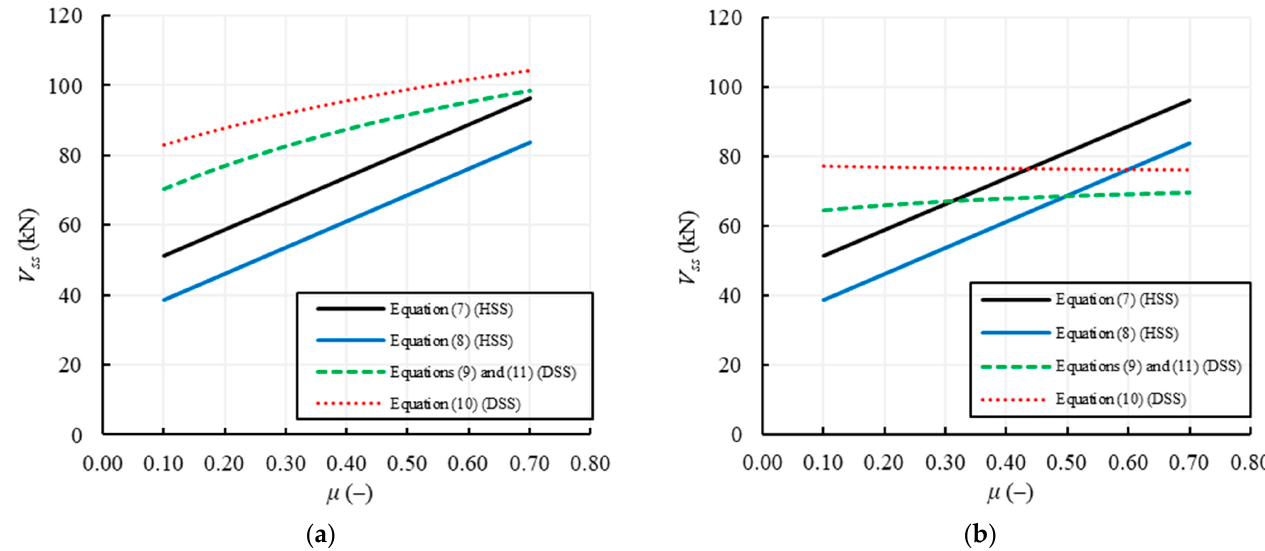
Figure 8. Sensitivity analysis for the shear capacity in regular masonry in function of µ , for f v0 = 0.25 MPa and: ( a ) h b /b b = 0.5; ( b ) h b /b b = 1.